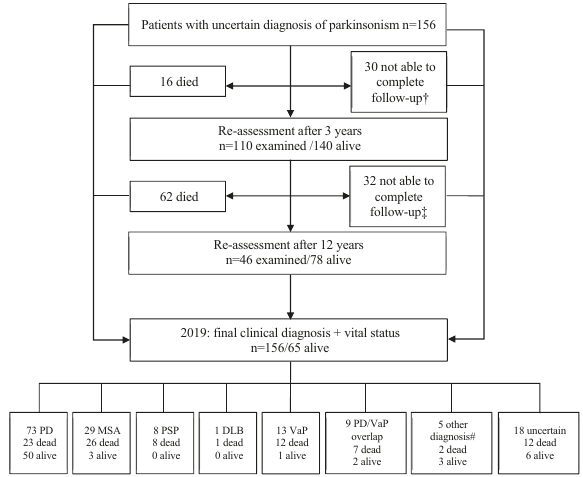
Fig. 1 Flowchart of the study participants in the discovery cohort, follow-up, survival, and diagnoses. † Follow-up information by telephone, survey, or medical chart ( n = 25), lost-to-follow-up ( n = 5). ‡ Follow-up information by telephone, survey, or medical chart ( n = 14), unable due to severe disease symptoms ( n = 4), not willing to participate ( n = 6), lost-to-follow-up ( n = 9). # Other diagnosis than neurodegenerative parkinsonism: idiopathic late onset cerebellar ataxia ( n = 1), functional tremor ( n = 1), medication-induced parkin- sonism ( n = 1), (stable) unilateral resting tremor without evidence of dopamine de fi cit on dopamine transporter imaging ( n = 1), and super fi cial hemosiderosis due to trombocytopenia ( n = 1). PD, Parkinson ’ s disease, MSA multiple system atrophy, PSP progressive supranuclear palsy, DLB dementia with Lewy bodies, VaP vascular parkinsonism.